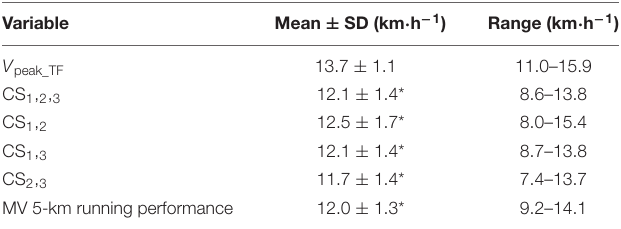
TABLE 1 | Mean ± SD and range obtained from the V peak_TF , CS values estimated through different TT combinations, and the MV for the 5-km running performance ( n =